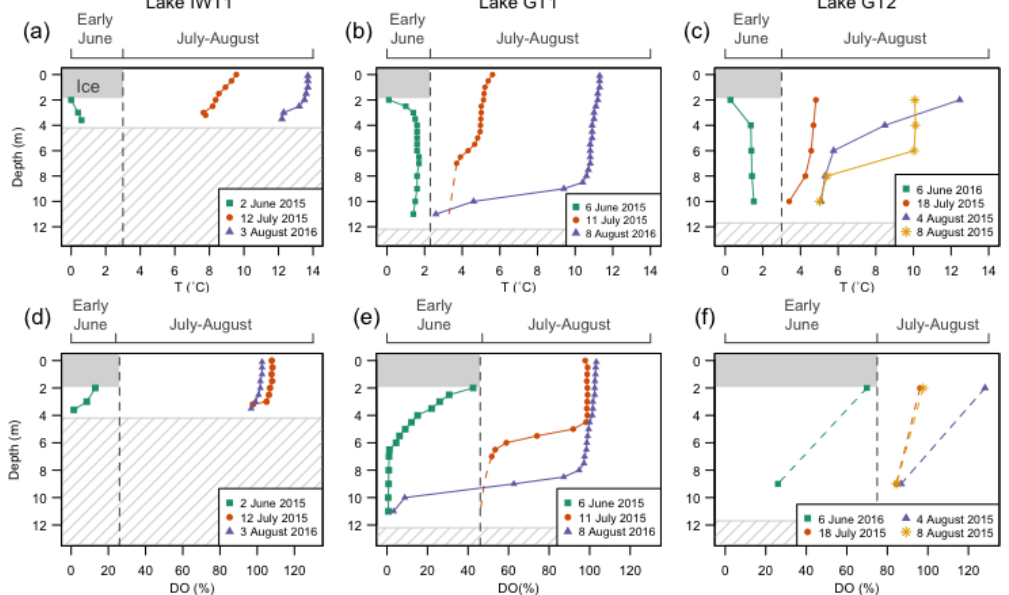
Figure 6. Early June, July and August temperature and dissolved oxygen (DO) profiles for ice-wedge thermokarst lake IWT1 (a, d) , as well as glacial thermokarst lakes GT1 (b, e) and GT2 (c, f) . The grey rectangle represents the ice cover in early June, and the average maximum ice thickness is 2m ± 20cm (measured in 2015 and 2016; Preskienis et al., 2021). For lake GT1 (b, e) , the dashed lines are simply connecting the two available data points (from the mooring), but the shape is likely to follow the more detailed temperature profiles. The hatched rectangle indicates the lake bottom. Note that the dates are slightly different in lake GT2. Profiles from lakes IWT1 and GT1 in early June and late summer (August) are adapted from Preskienis et al. (2021; respectively corresponding to lakes BYL66 and BYL36), allowing us to compare them with lake